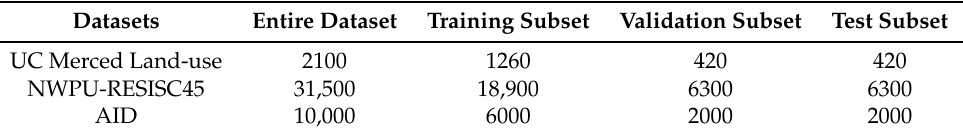
Table 1. Sample sizes for different datasets.